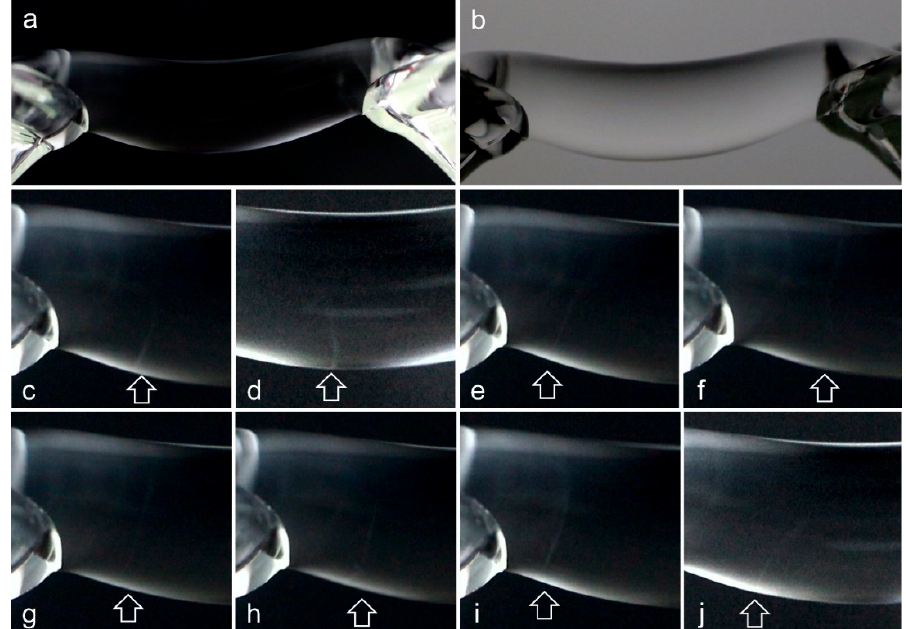
Figure 5. A water bridge between crossed polarizers ( a ) and under normal illumination ( b ). The bright areas below that correspond to the dark areas above show regions of simple reflections. The fine vertical lines in the bridge ( c–j ) are ring-like scatter centers moving fast through the bridge from anode to cathode.